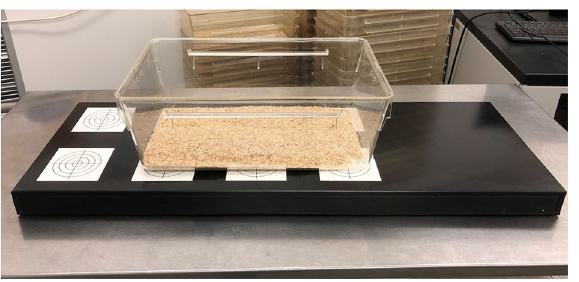
Figure 1. Overview of the radio telemetry tracking system. The radio telemetry platform is made up of eight antennas generating electromagnetic fields. A polycarbonate cage is placed on top of